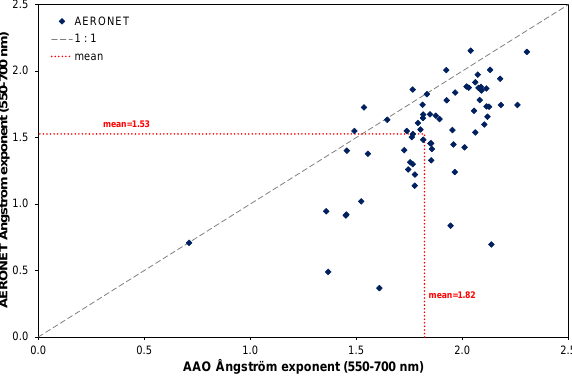
Fig. 4. Comparison of AAO aircraft calculated hemispheric backscatter fraction and asymmetry parameter with AERONET hemispheric backscatter fraction (calculated from the phase func- tion and adjusted to 550nm) and asymmetry parameter (adjusted to